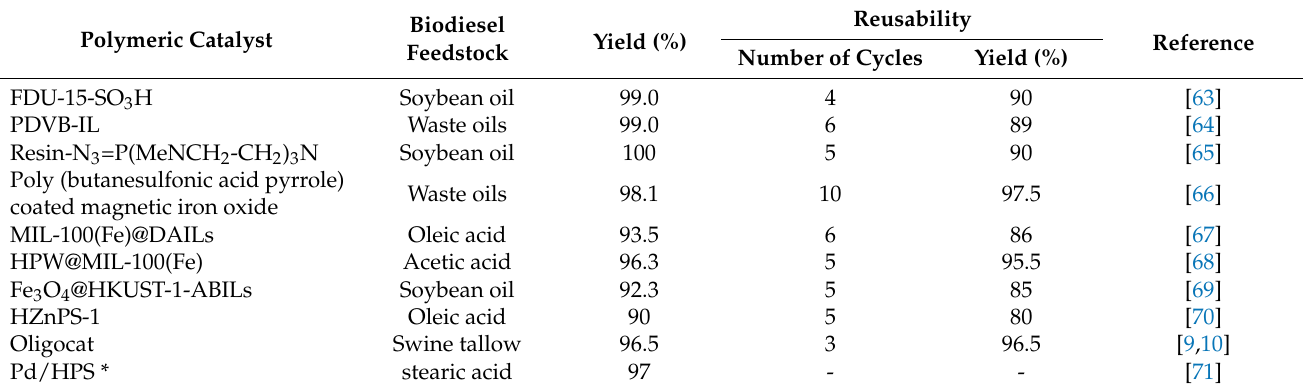
Table 4. Some of the chemically synthesized polymeric